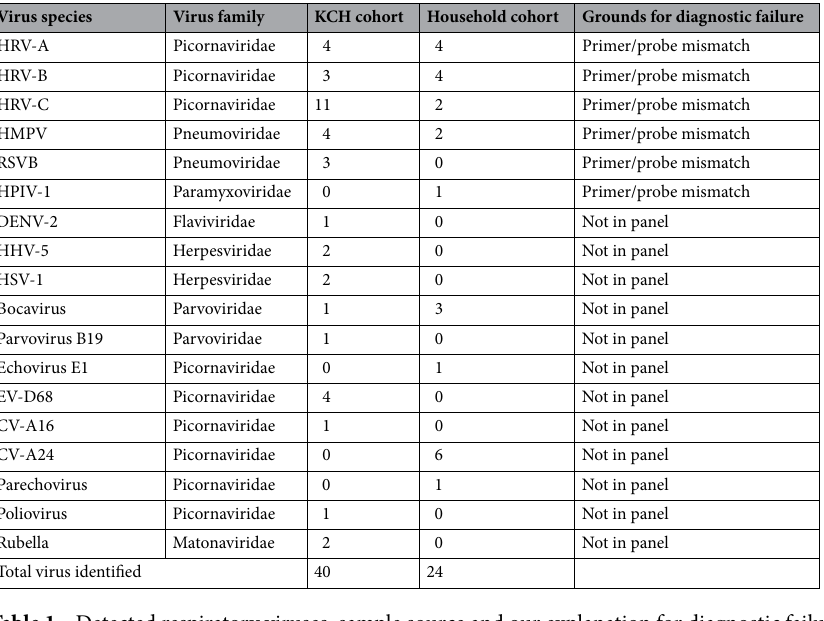
Table 1. Detected respiratory viruses, sample source and our explanation for diagnostic